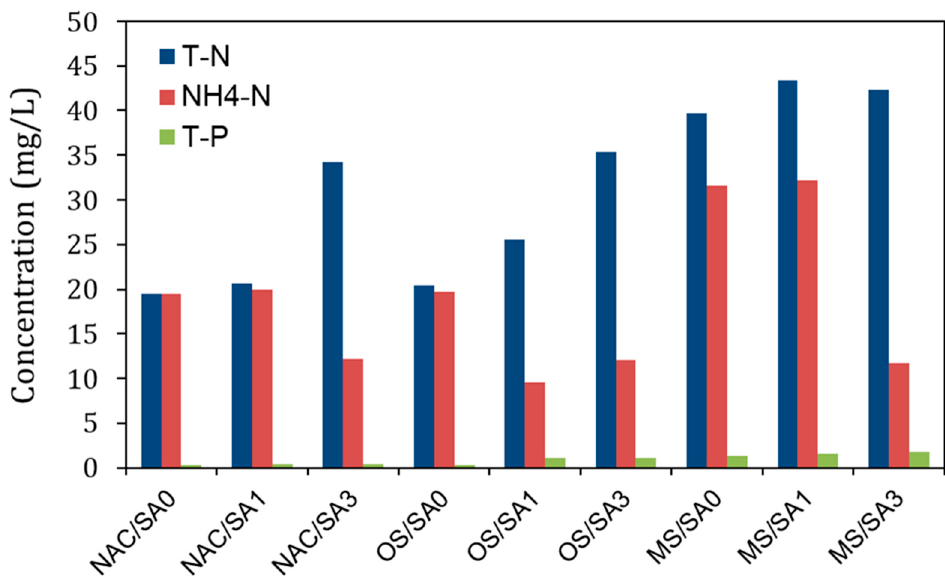
Figure 4. T-N, NH 4 -N, and T-P concentrations in pore water following the completion of the incubation experiments.